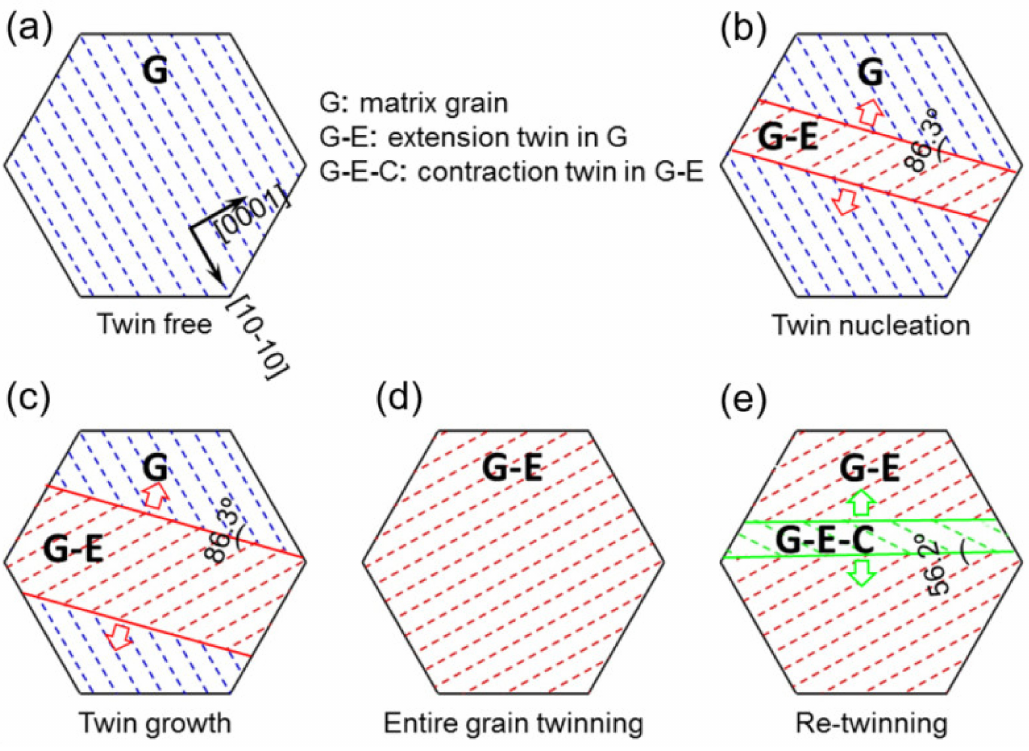
Figure 15. Schematic of twinning and double twinning in a grain. ( a ) The un-twinning grain (G: substrate grain), where the dotted blue lines stand for the matrix basal plane in a coordinate of [10-10] vs. [0001]. ( b ) Twinning formation: introduction of twin nucleation, where the solid red lines represent extension TBs, and the dotted red lines denote the twin basal plane (G-E: extension twin formed in G). ( c ) Twinning growth: growth of the extension twin with the nucleation and slip